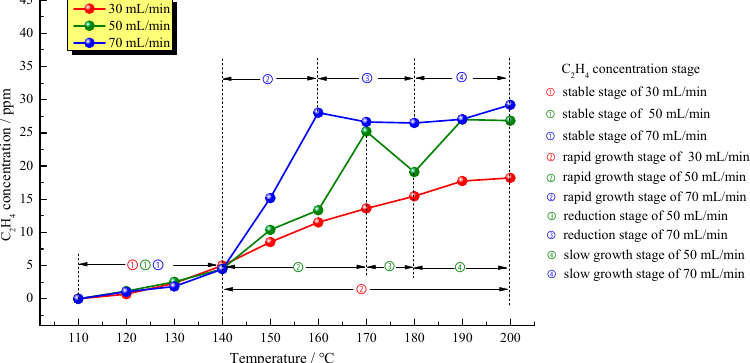
Figure 7. Relationship between the C 2 H 4 concentration and the temperature at different air supply rates.